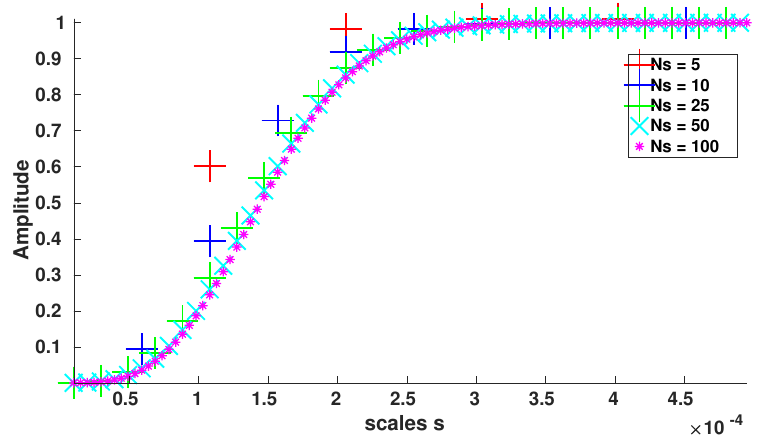
Figure 10. Pressure L 2 -energy recovered for s ∈ [10 − 5 , 5 × 10 − 4 ] - σ = 1 - t = 1.6 × 10 − 4